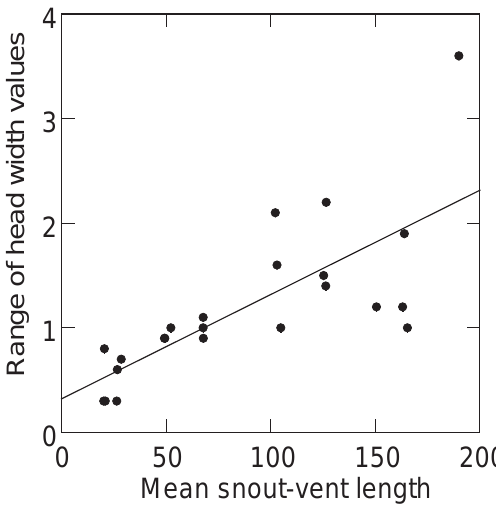
Fig. 2 – Measurement error data for head width with linear smoother. All values in mm. Measurement errors were greatest for the largest specimens. In general, more